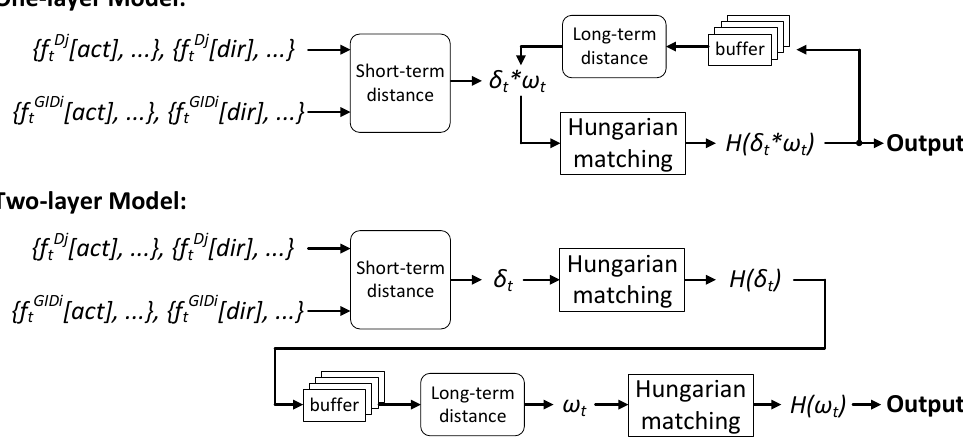
Figure 7. The proposed one-layer and two-layer pairing models.